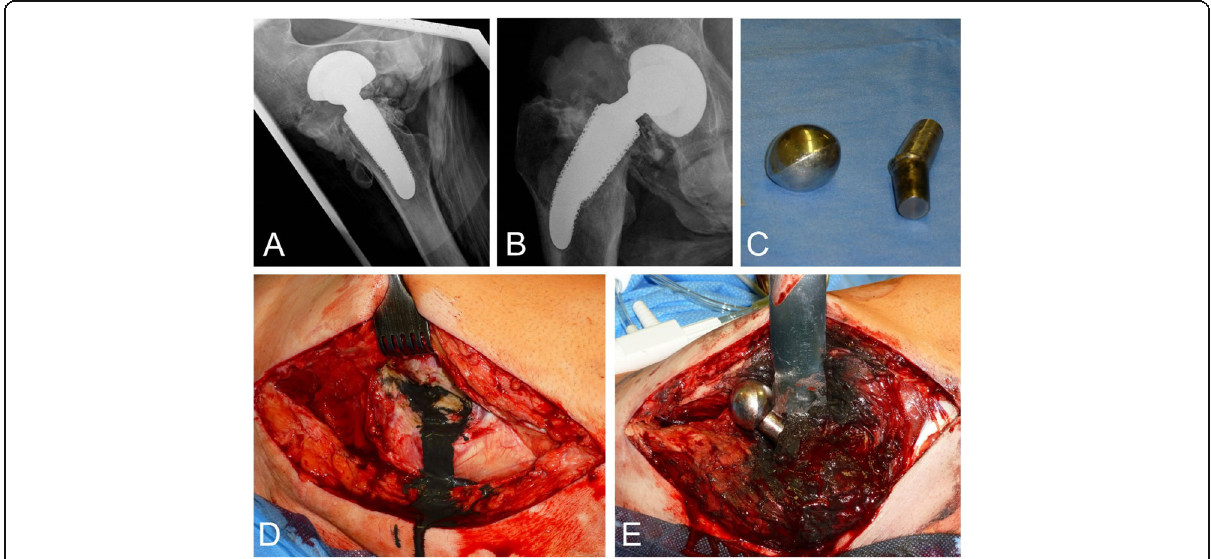
Fig. 1 X-ray of the right hip joint in two planes: A ) mediolateral projection and B ) anterior-posterior projection show a decentered prosthesis head as evidence of inlay wear but no evidence of periprosthetic fracture or material loosening. Pronounced, periarticular heterotopic ossification ( A ) with bridging of the joint space (grade 4 according to Brooker). Flaw changes in the density of the peri-prosthetic region hint toward heavy metal abrasion. Streaky calcifications consistent with myositis ossificans (especially seen in A ) in projection to the adductors and rotators indicate local inflammation probably related to metal abrasion. C Explanted femoral head and neck. Note the massive wear of the head, which was round at the time of implantation. D Leakage of black synovial fluid after removal of the hip joint capsule. E Massive metallosis and synovialitis after luxation of the hip joint. Abrasion of the femoral head of the